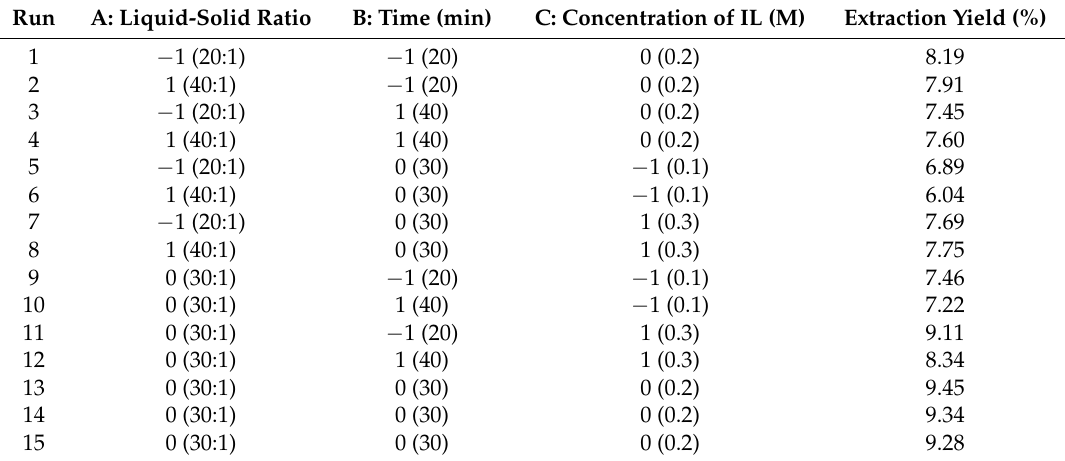
Table 1. Box-Behnken design with the observed response for extraction yield (%) of total ginsenosides using